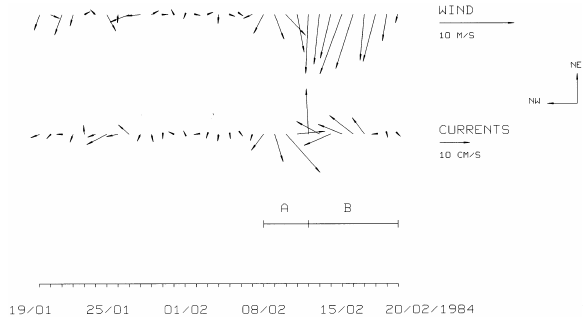
Fig. 5. Low-pass filtered series of the wind vectors registered at the height of 10m above the ground at the meteorological station Pula airport and of the currents registered at 5-m depth at the gas field Ivana from 19 January to 19 February 1984. Also indicated are episodes A and B discussed in the